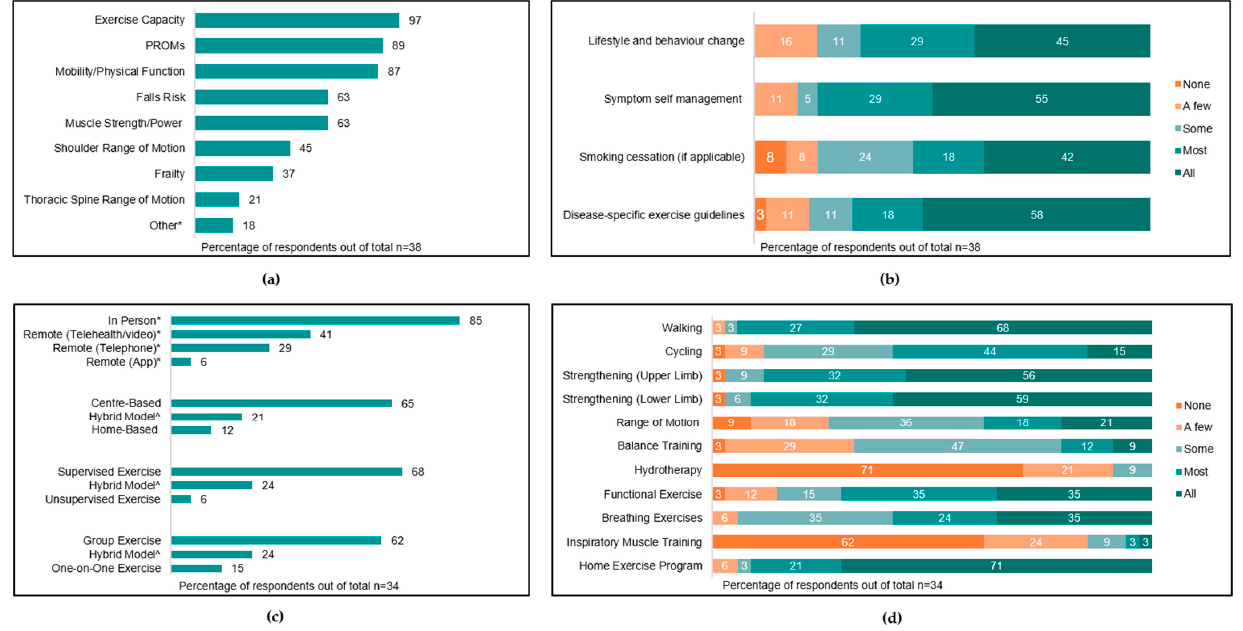
Figure 6. Community/outpatient assessment and management of people post surgical resection